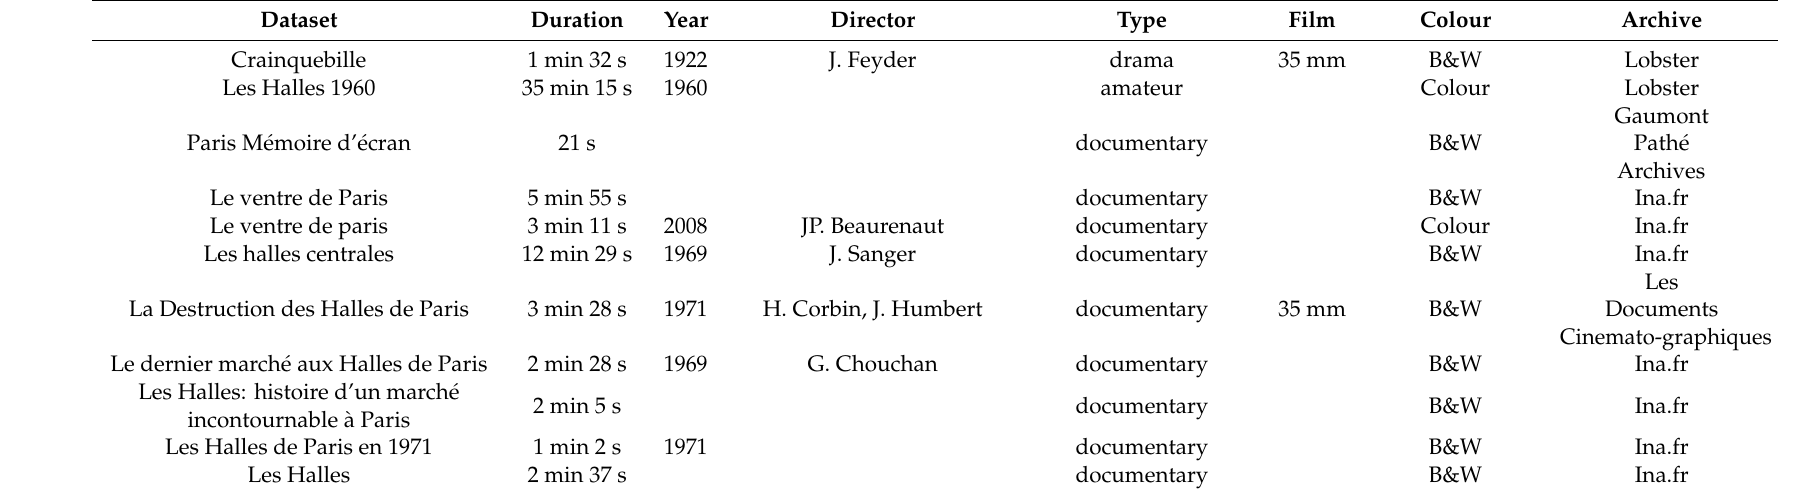
Table 3. Description of the video dataset of Les